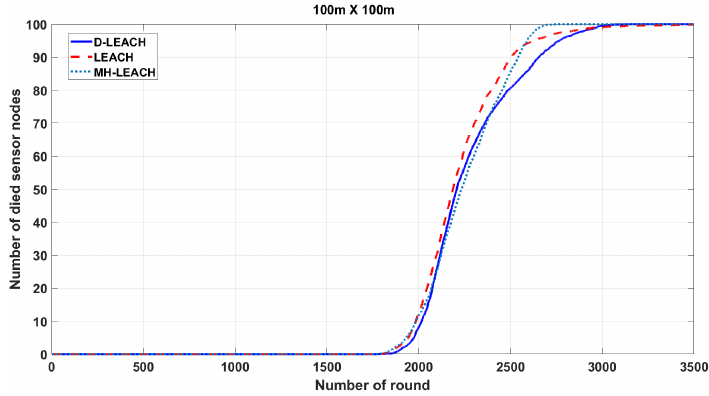
Figure 13. The number of dead sensor nodes in wireless sensor networks (WSNs) (100 × 100 m 2 ).